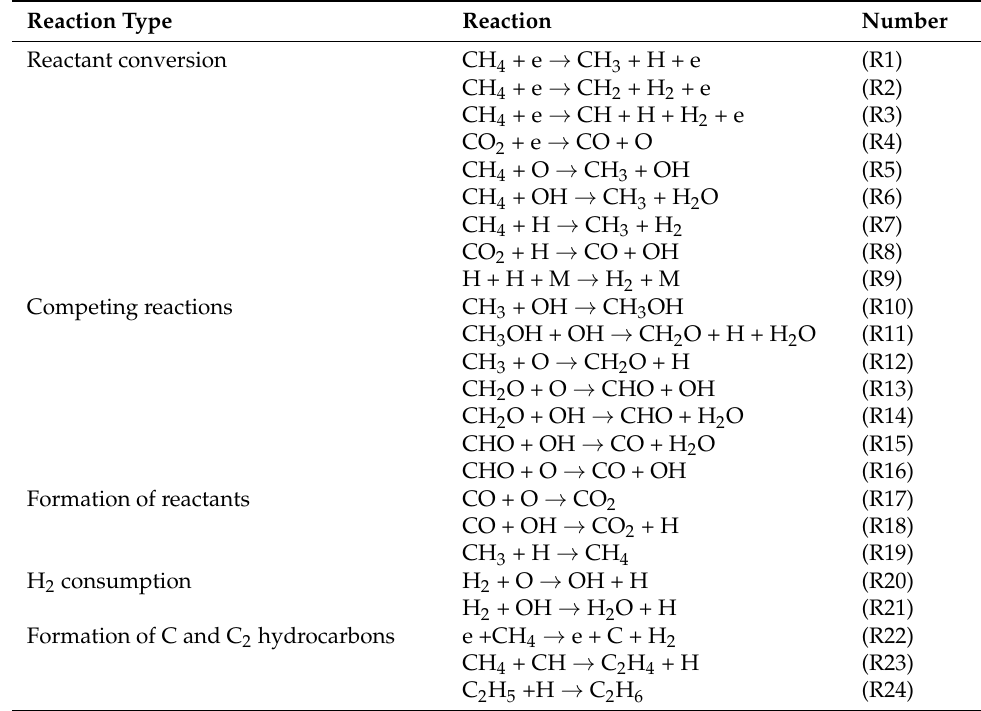
Table 3. Electron impact reactions taking place during the dry reforming of methane